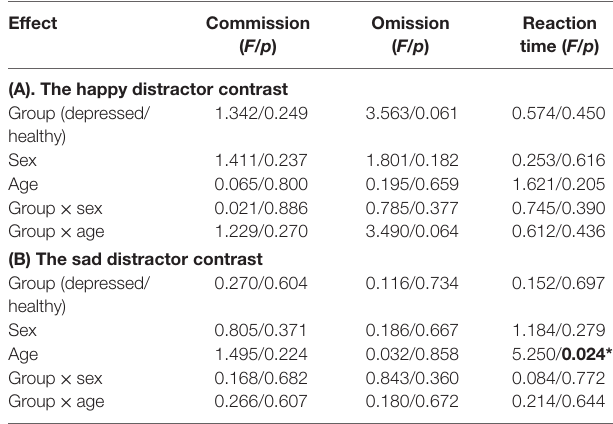
TaBle 2 | Behavioral results.